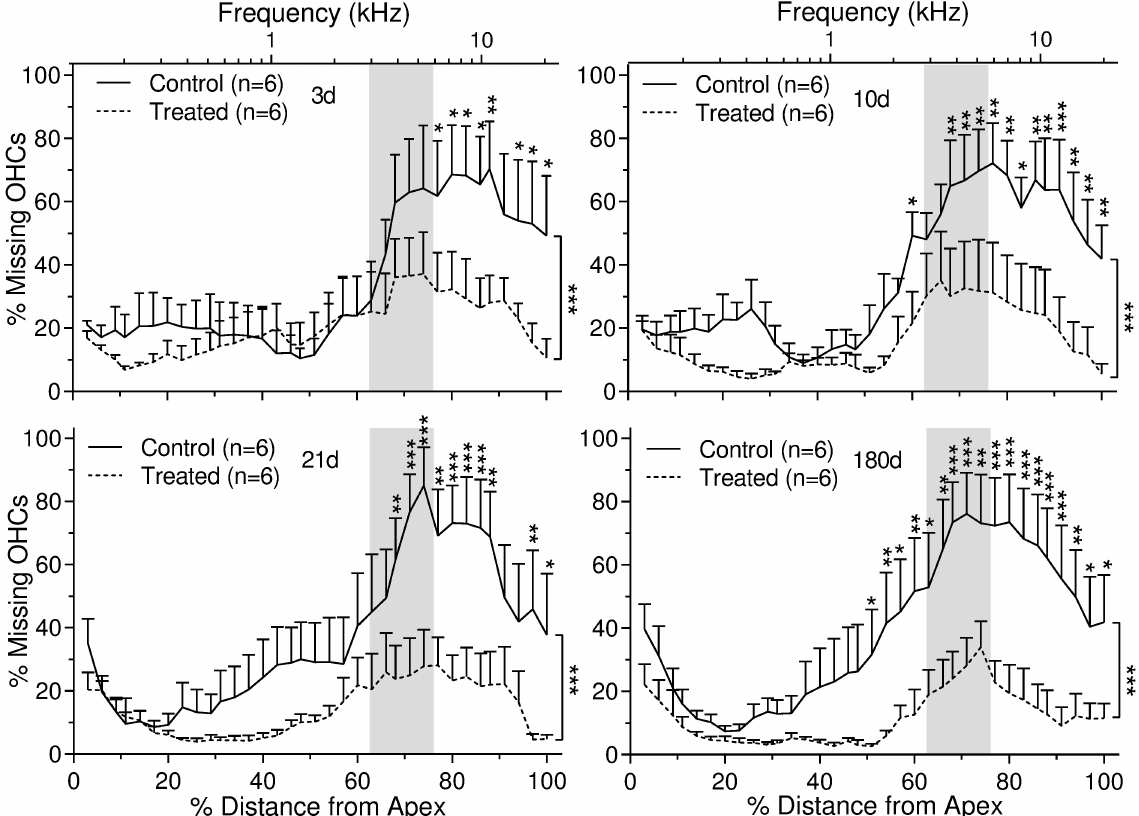
Fig 9. Percent of outer hair cell (OHC) loss as a function of percent distance (and frequency-specific tonotopic position) from the OC apex in untreated and HPN-07-treated chinchilla at 3 days (d), 10 d, 21 d, and 180 d after noise exposure. The data are plotted as mean ± SEM and “n” represents the numberof cochleae.Vertical lines at right of figures show a significant difference of mean values for noise only "Control" and Treated" groups as determinedby two- way ANOVA followedby Bonferroni post-tests: * , p < 0.05; ** p < 0.01; *** p < 0.001. Shadedarea demarcates the range of noise exposure centeredat 4 kHz. Significantlyless OHC loss was observed in the basal turn of the OC in the HPN-07 "Treated" group ( p < 0.05, 0.01 or